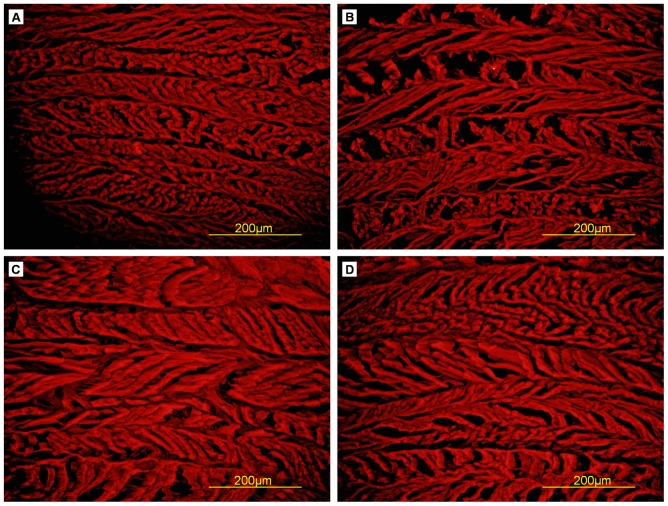
Collagen I immunoﬂuorescent staining of cross-sections of AF samples.(A) Triton X-100, (B) SDS, (C) trypsin, (D) control.